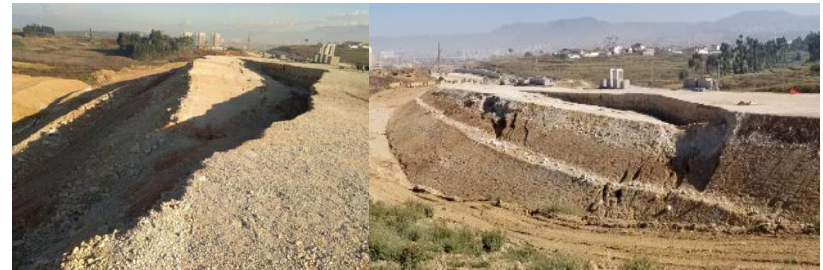
Figure 12. Tensile Cracks at the rear edge of Embankment Landslide.